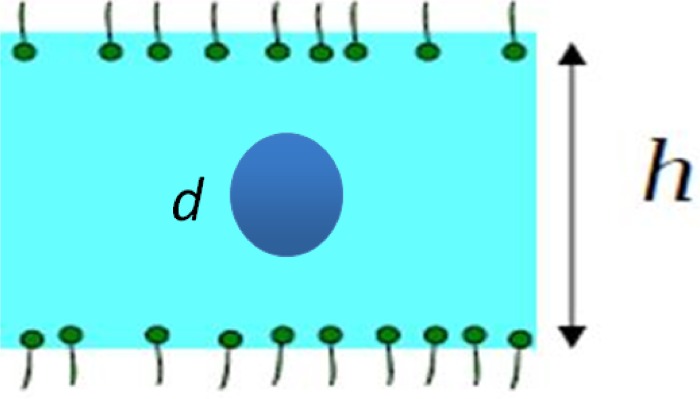
Cartoon depicting soap film of thickness h, with a single representative particle of diameter d < h.On both air-film interfaces, representative soap molecules are shown. As discussed in the text, we believe it is likely that particles with d < h sit in the interior of the film, but we cannot rule out the possibility that some particles are trapped at the air-film interface.